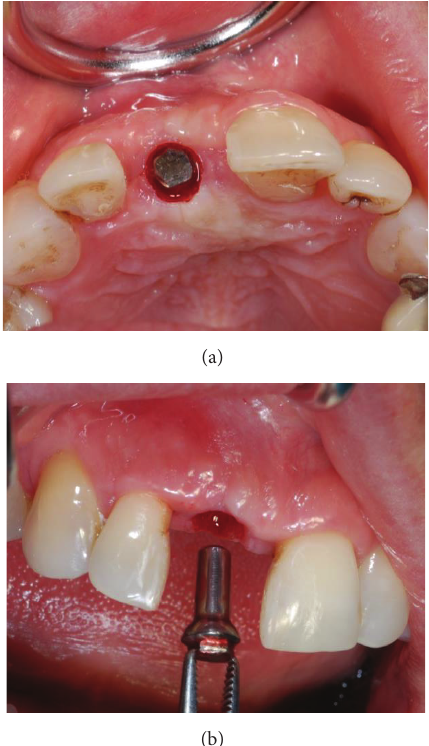
Figure 19: After performing a circular incision (a), the provisional stealth abutment was removed (b).